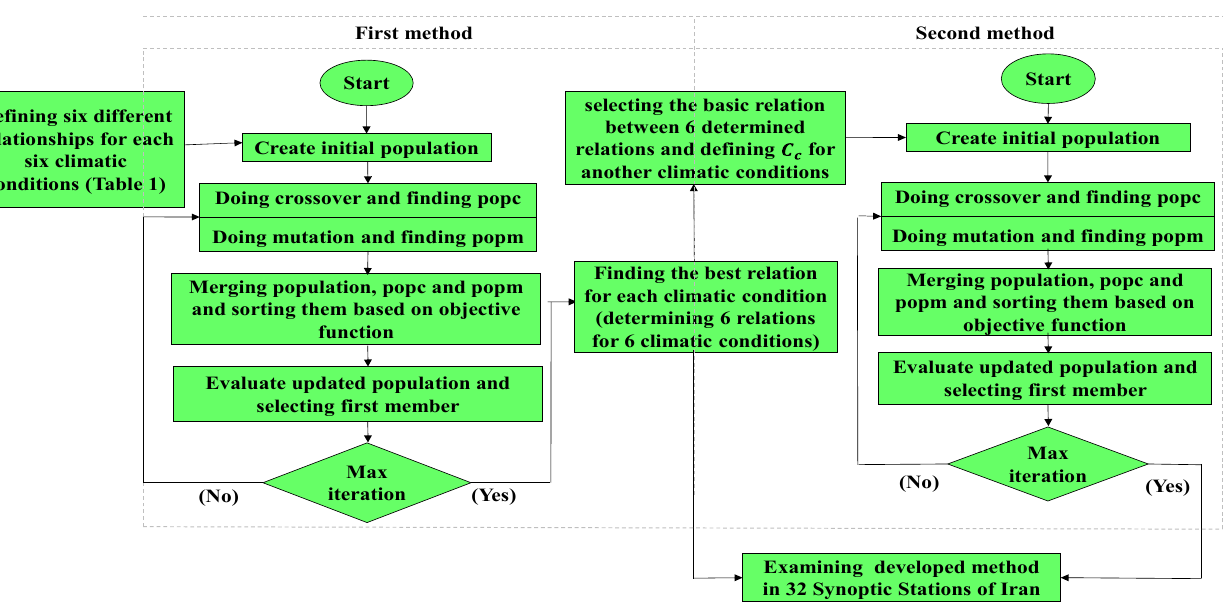
Table 2. Climatic classification for Iran based on the De Martonne method.